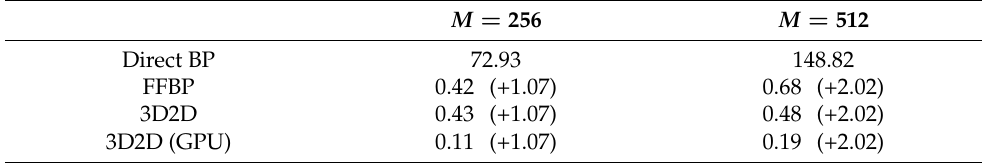
Table 6. Processing times for different algorithms. All the numbers are in